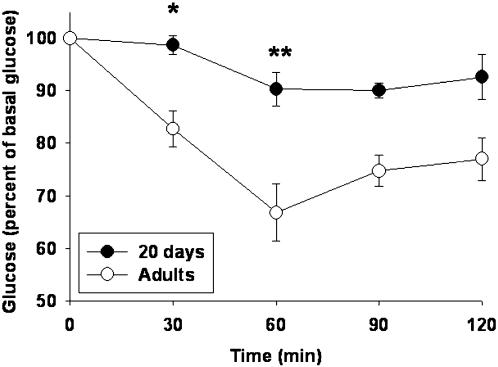
Insulin tolerance test (ITT) at d20 and adults. ITTs were performed in groups (n  =  6) of anesthetized 20d and adult rats.Insulin (0.2 U/kg) was administered iv via a femoral catheter and blood samples were withdrawn for glucose measurements at the times shown; (*) p<0.05 with respect to adults.